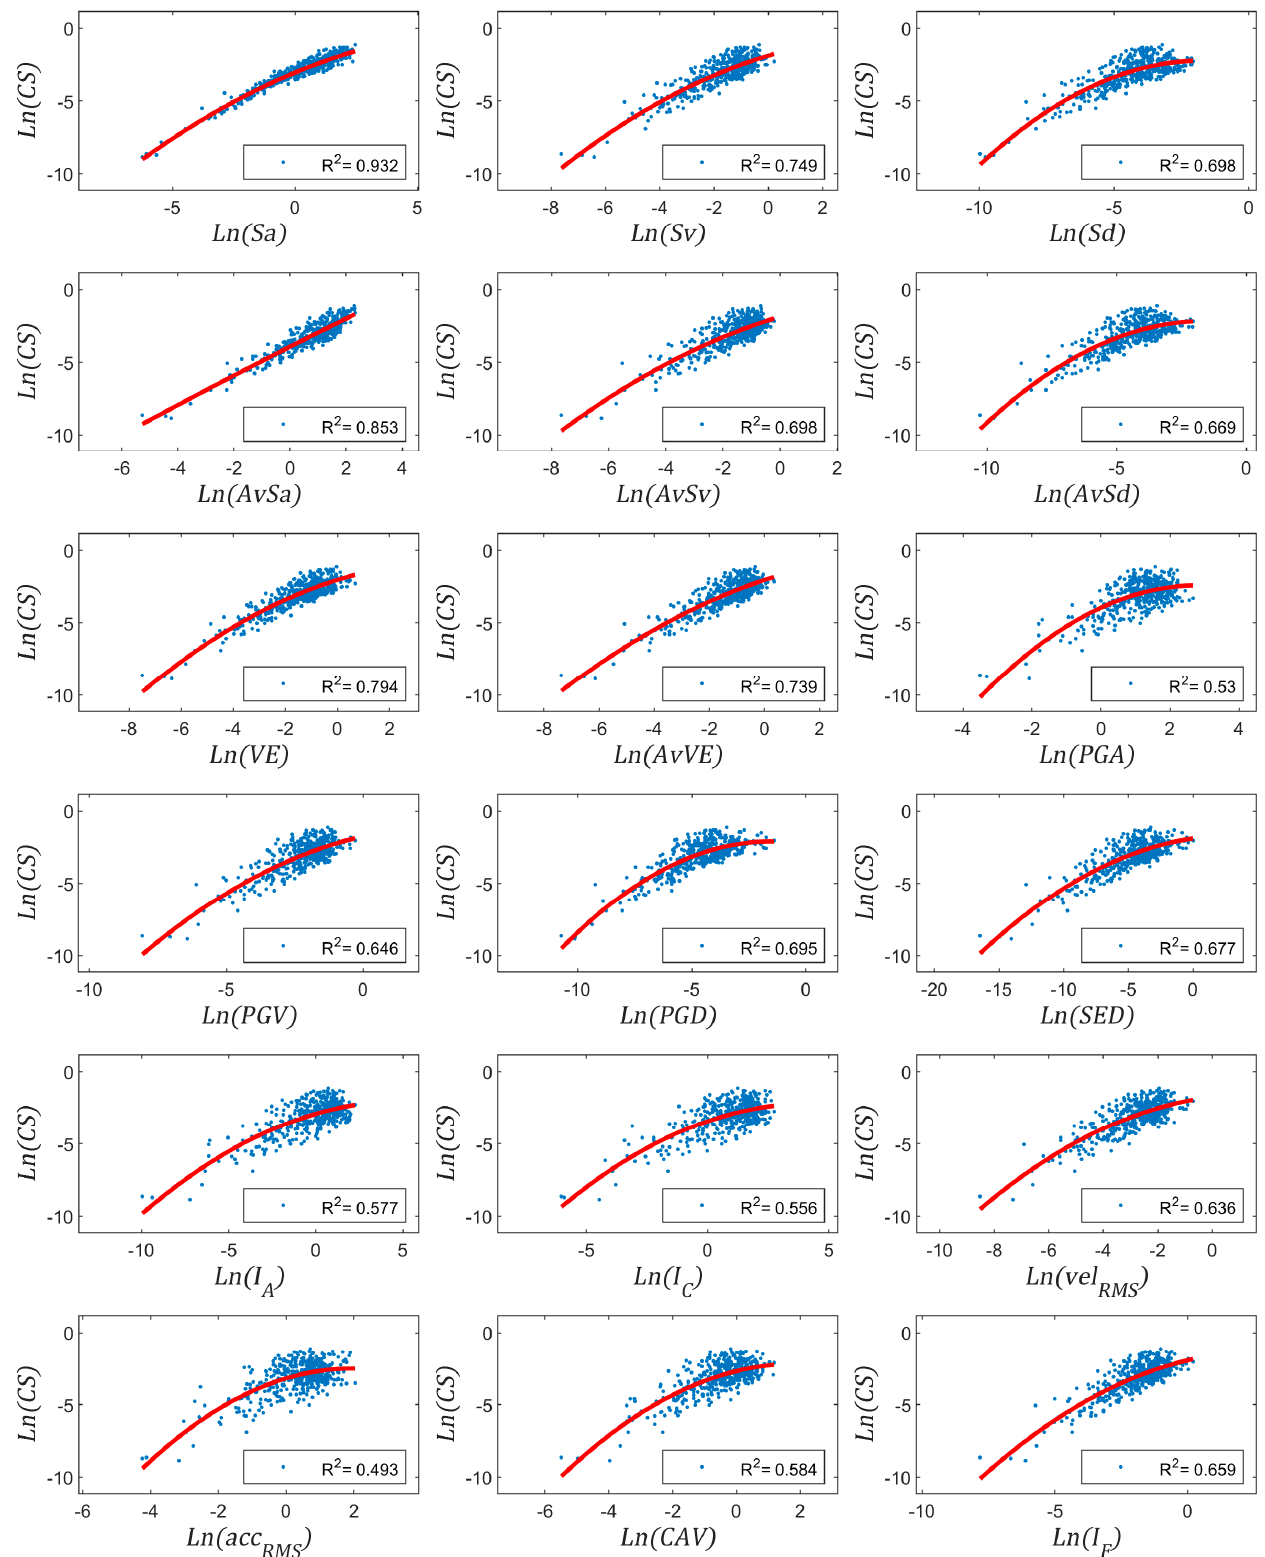
Figure 7. Correlation coefficient between IMs and CS in the log-log space for near-fault records.